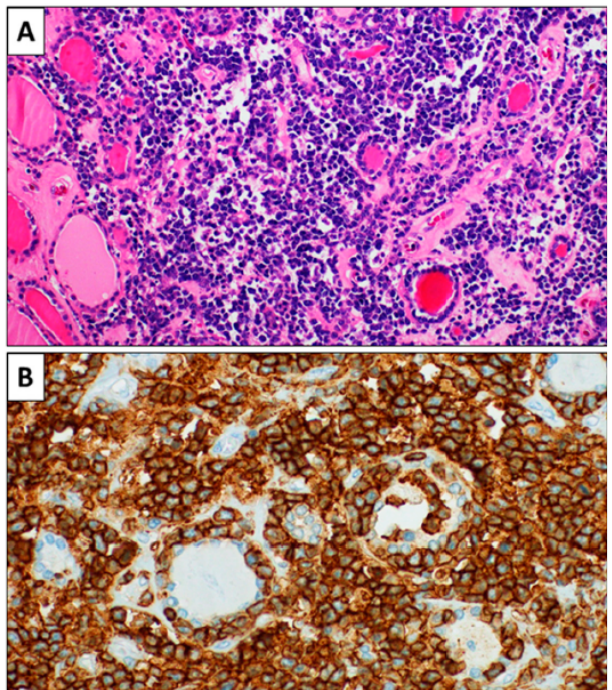
Figure 4. ( A ): Histological examination showing a dense lymphoid population constituted by large cells. Some thyroid follicles are recognizable on the left side (H&E, 20 × ). ( B ): The lymphoid cells show immunohistochemical expression of CD20. Some CD20-negative thyroid follicles are present in the context. (CD20 immunohistochemistry, 40 ×